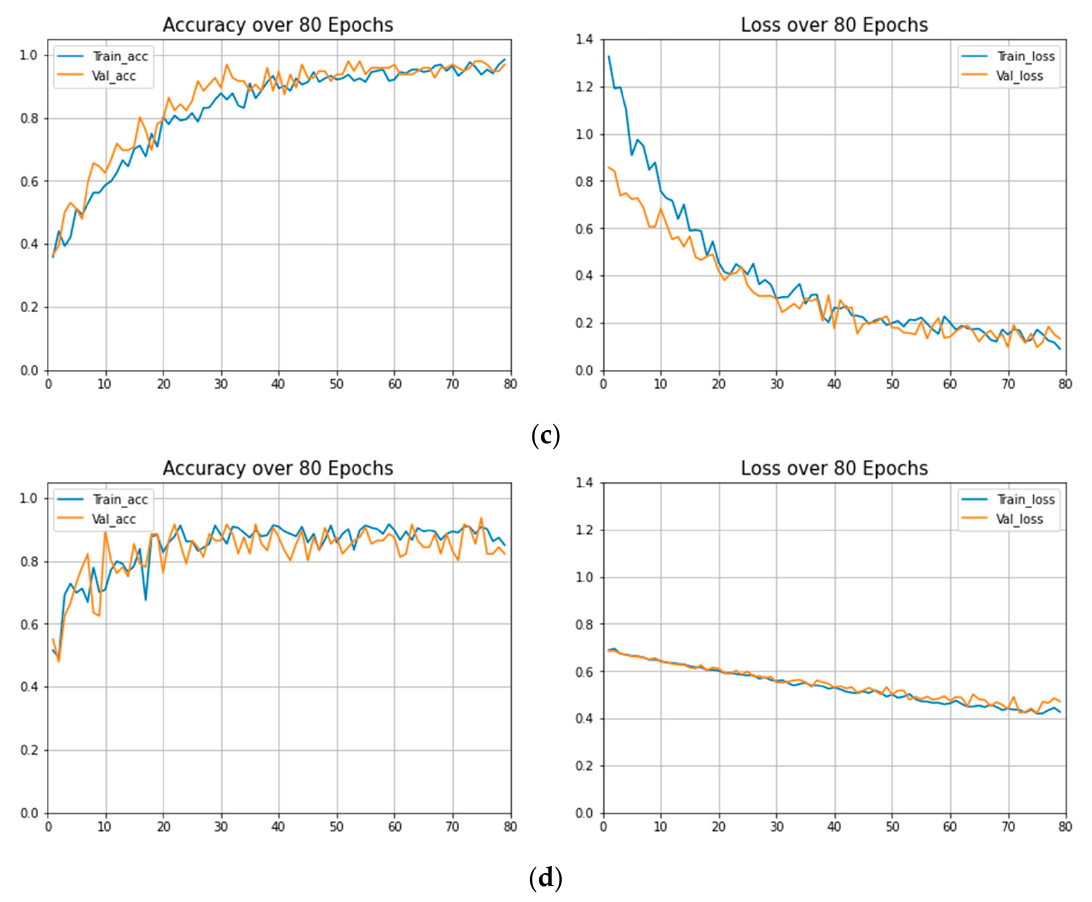
Figure 10. Training accuracies vs. validation accuracies and training loss vs. validation loss: ( a ) MobileNet; ( b ) ResNet-50; ( c ) DenseNet; ( d )